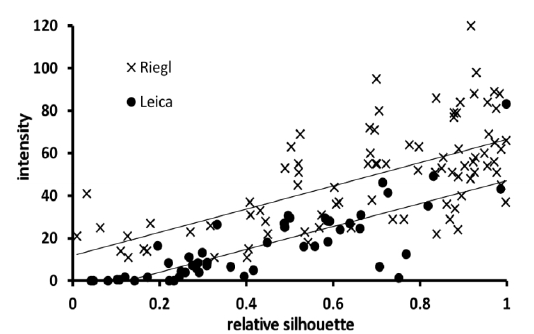
Figure 6. Dependence between non-weighted relative silhoue- tte area and the intensity of the first echo in pine shoots for 1 km Riegl (38 cm footprint) and Leica (26 cm) data.